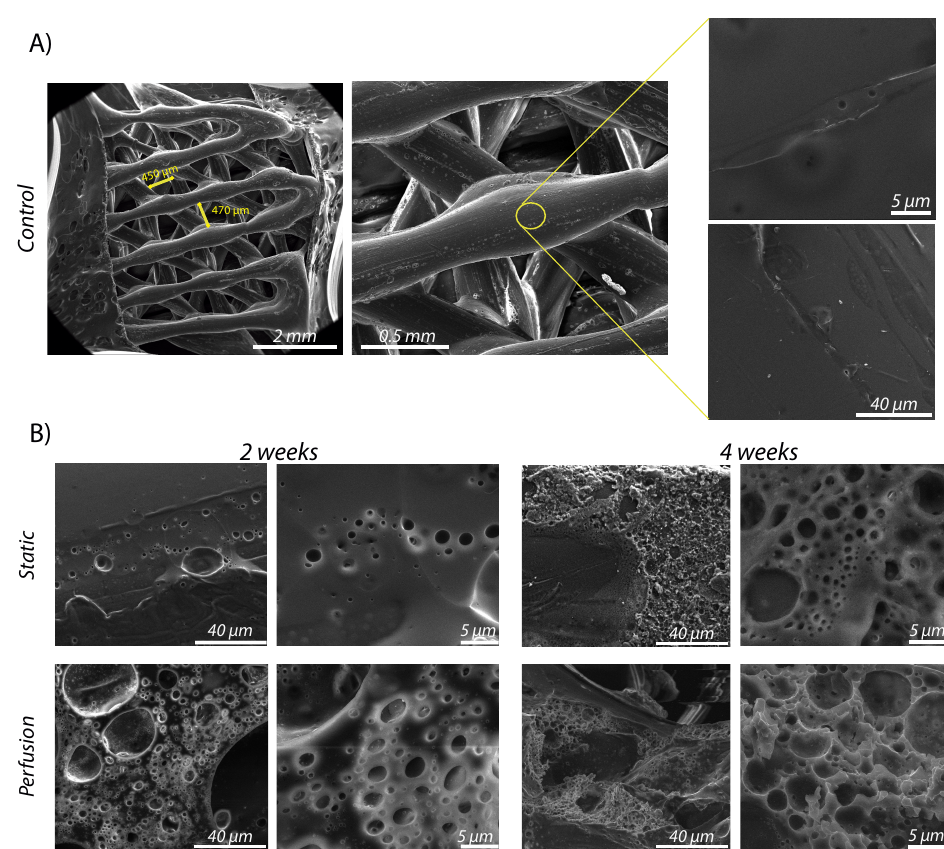
Figure 4. Representative SEM images: ( A ) view of macro porosity and 2500 × and 10,000 × magnifica- tion of a non-incubated scaffold ( B ) samples incubated for 2 and 4 weeks under different conditions: static and dynamic (at 2500 × and 10,000 × magnification).